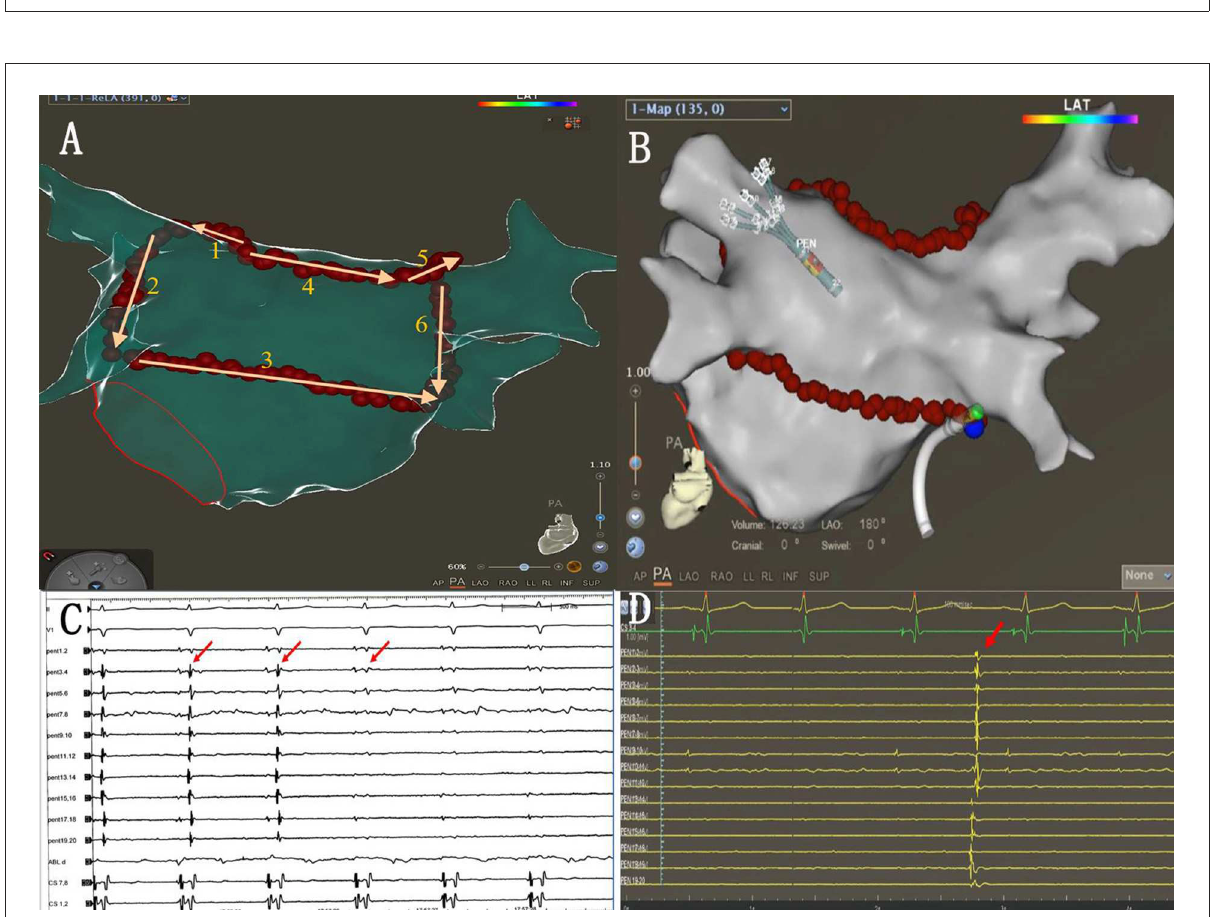
FIGURE2 (A) Sequence of linear ablation. (B) The ablation line was completed at the bottom of the right pulmonary veins (blue dots indicate the last ablation point). (C) When the ablation line was completed, PVI was also completed (red arrows). (D) Autonomic potentials recorded with PENTARAY ® catheter within the ablation